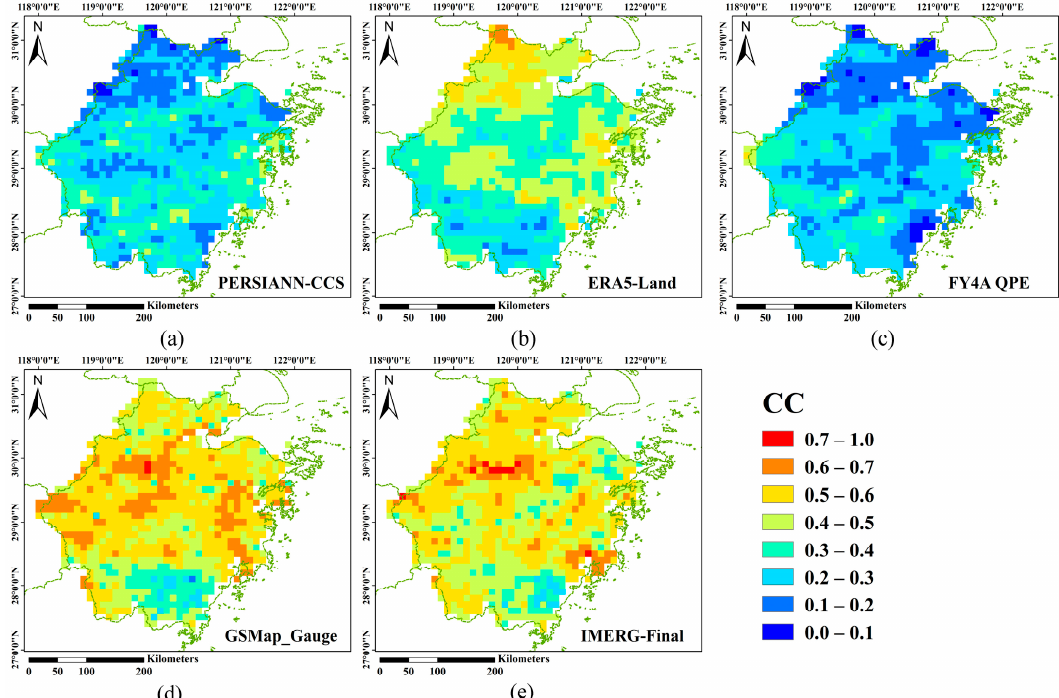
Figure 3. Spatial patterns of CC based on ( a ) PERSIANN-CCS ( b ) ERA5-Land, ( c ) FY4A QPE ( d ) GSMap_Gauge, and ( e ) IMERG-Final against CMPA at an hourly scale over the Zhejiang province in summer, from June to August 2019.